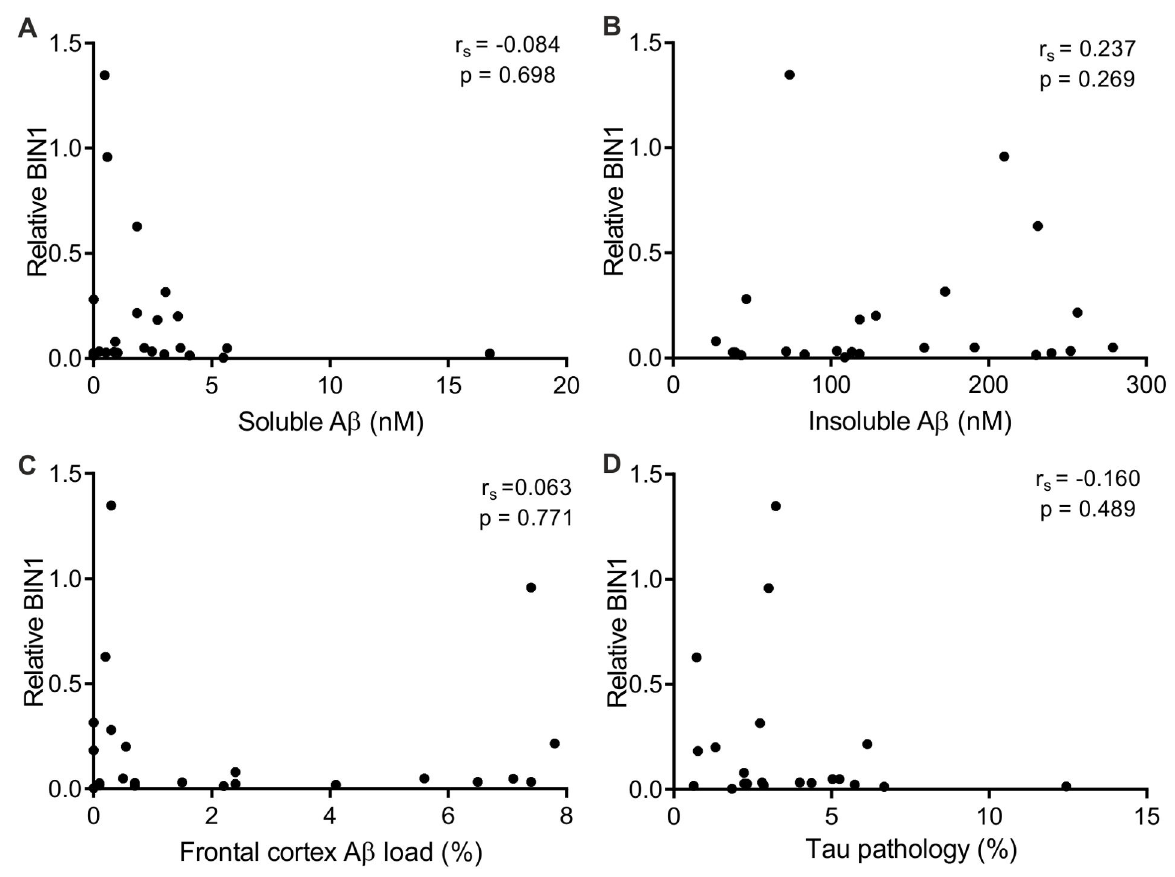
Figure 2. BIN1 does not correlate with soluble or insoluble Aβ, Aβ load or Tau pathology in sporadic AD samples. Relative BIN1 protein levels of sporadic AD samples were plotted against soluble Aβ (A), insoluble Aβ (B), Aβ load (C) and tau pathology (D) for each subject in the cohort (n = 24). BIN1 does not correlate with soluble Aβ, insoluble Aβ, Aβ load and tau pathology as determined by Spearman’s rank correlation coefficient (r s